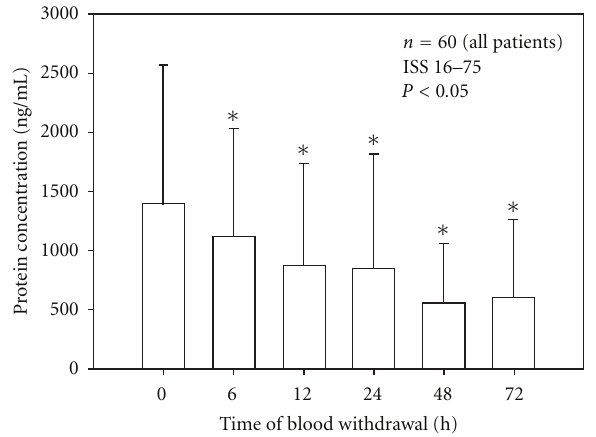
Figure 1: Significant decrease of mean MMP-9 serum levels in the early posttraumatic period in comparison to initial mean MMP-9 serum concentrations at 0h after the traumatic event. Data were analyzed by Mann-Whitney Rank Sum test and presented by mean ± standard error of the mean ( ∗ P < 0 . 05).